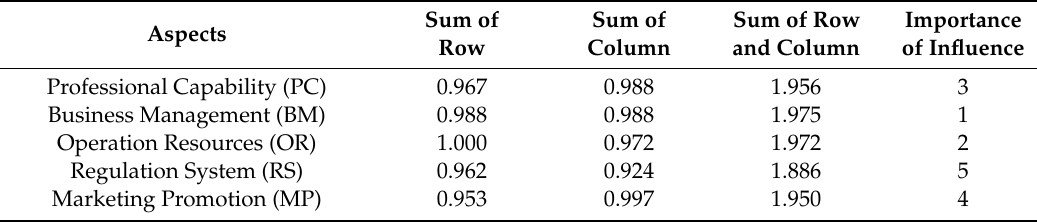
Table 6. The degree of direct influence.